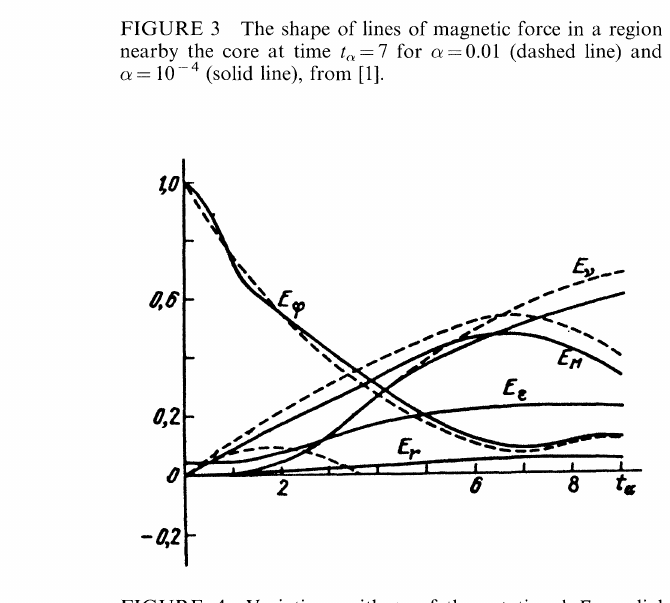
FIGURE 4 Variations with t of the rotational Ee, radial kinetic Er, internal thermal E, magnetis EM energies, of the neutrino energy losses E for c 0.01 (solid line) and c= 10 -4 (dashed line). All the quantities are normalized to the maximum rotational energy E 1047erg/cm per unit cylinder length,